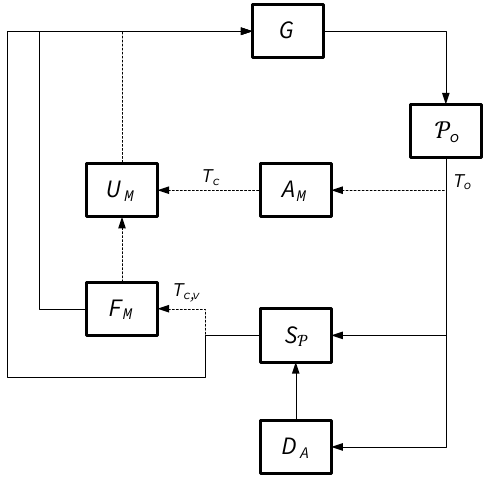
Figure 2. The control system